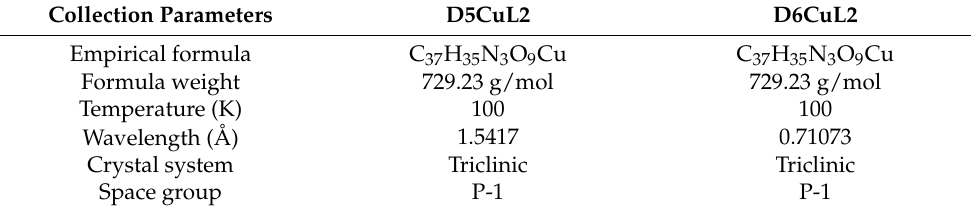
Table 7. Crystallographic data and structural refinement parameters for D5CuL2 and